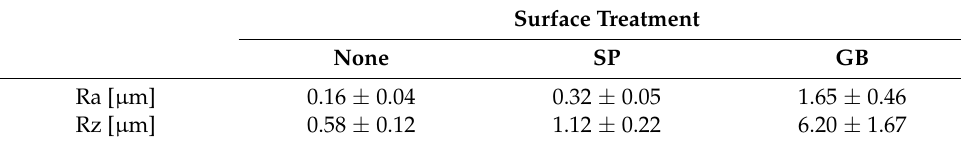
Table 3. Values of surface roughness of aluminium for the non-treated and treated surface conditions. Surface